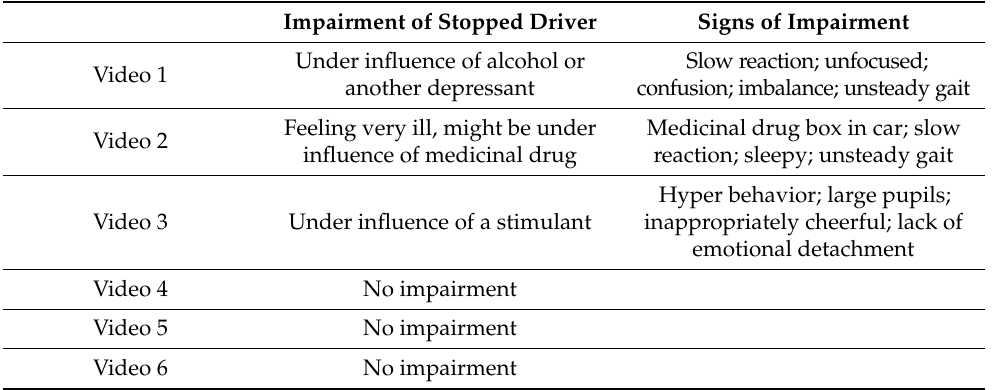
Table 3. Details of videos showing staged traffic